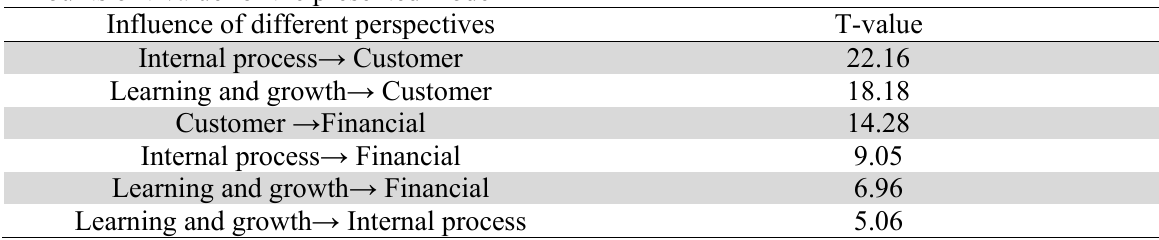
Amounts of t-value for the presented model